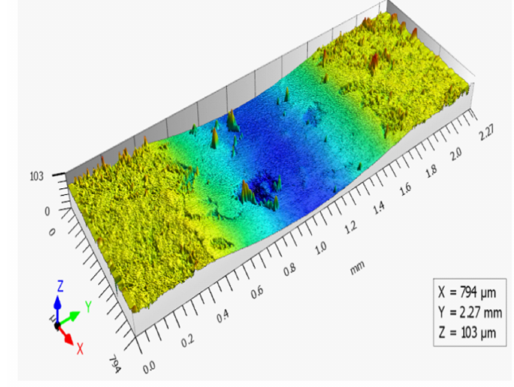
Figure 5. Topographic map of wear